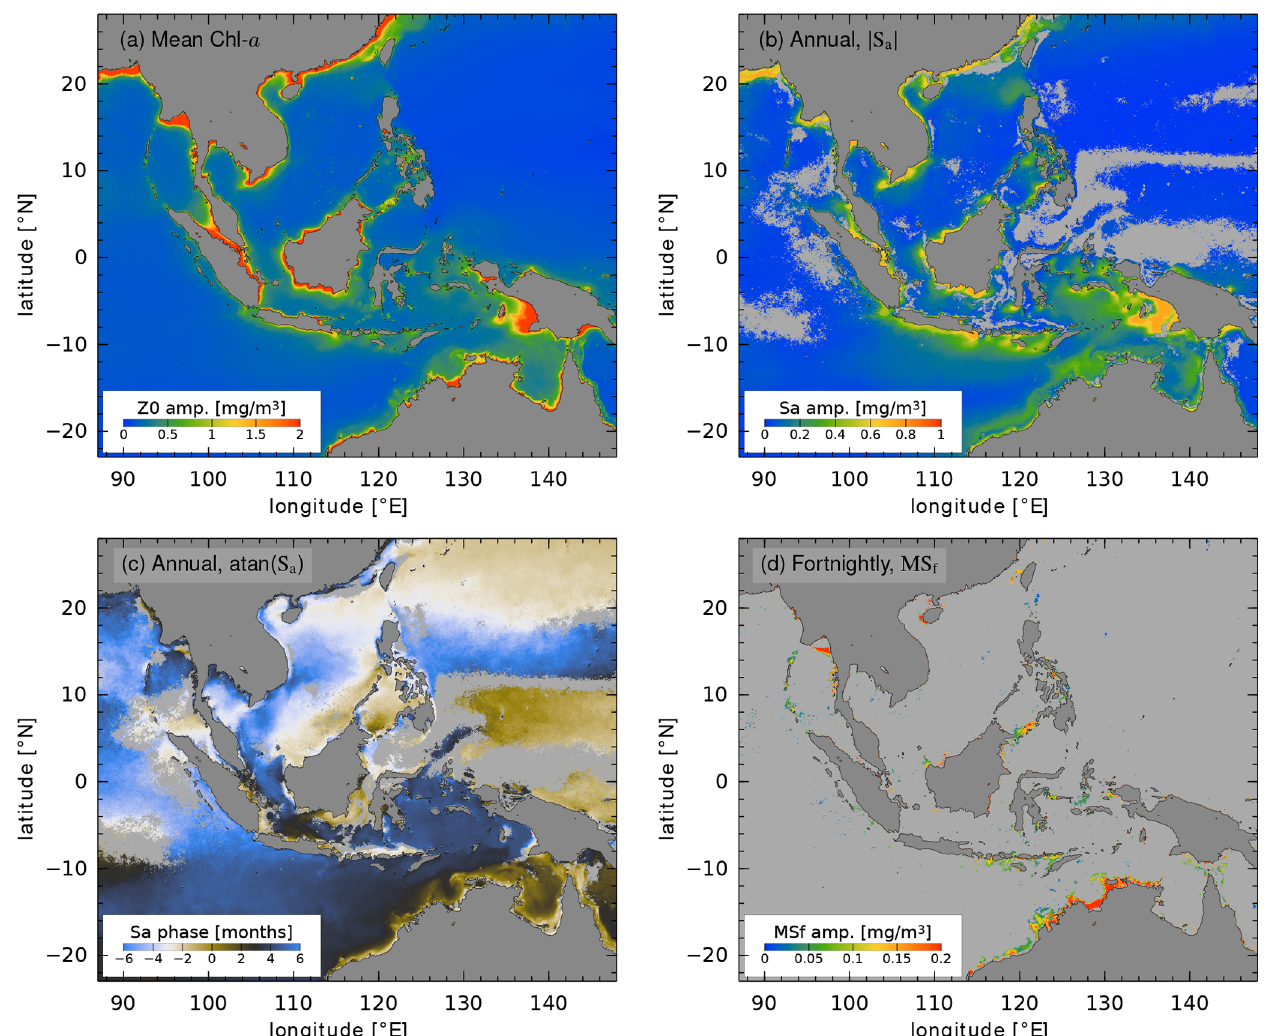
Figure 3. Results of harmonic analysis of Chl a concentration: (a) mean, (b) amplitude of annual cycle ( S a ), (c) phase of S a , measured relative to the vernal equinox (20 March; brown corresponds to a maximum in February–April, black to May–July, blue to August–October, and white to November–January), and (d) amplitude of the fortnightly cycle (MS f ). Two shades of gray are used to indicate land (dark gray) and non-significant amplitude compared to the noise estimate (light gray). Note the different color scale used in each